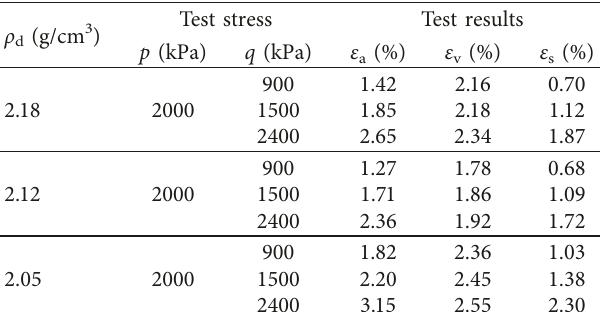
Table 5: Test stress conditions and test results (different dry densities).